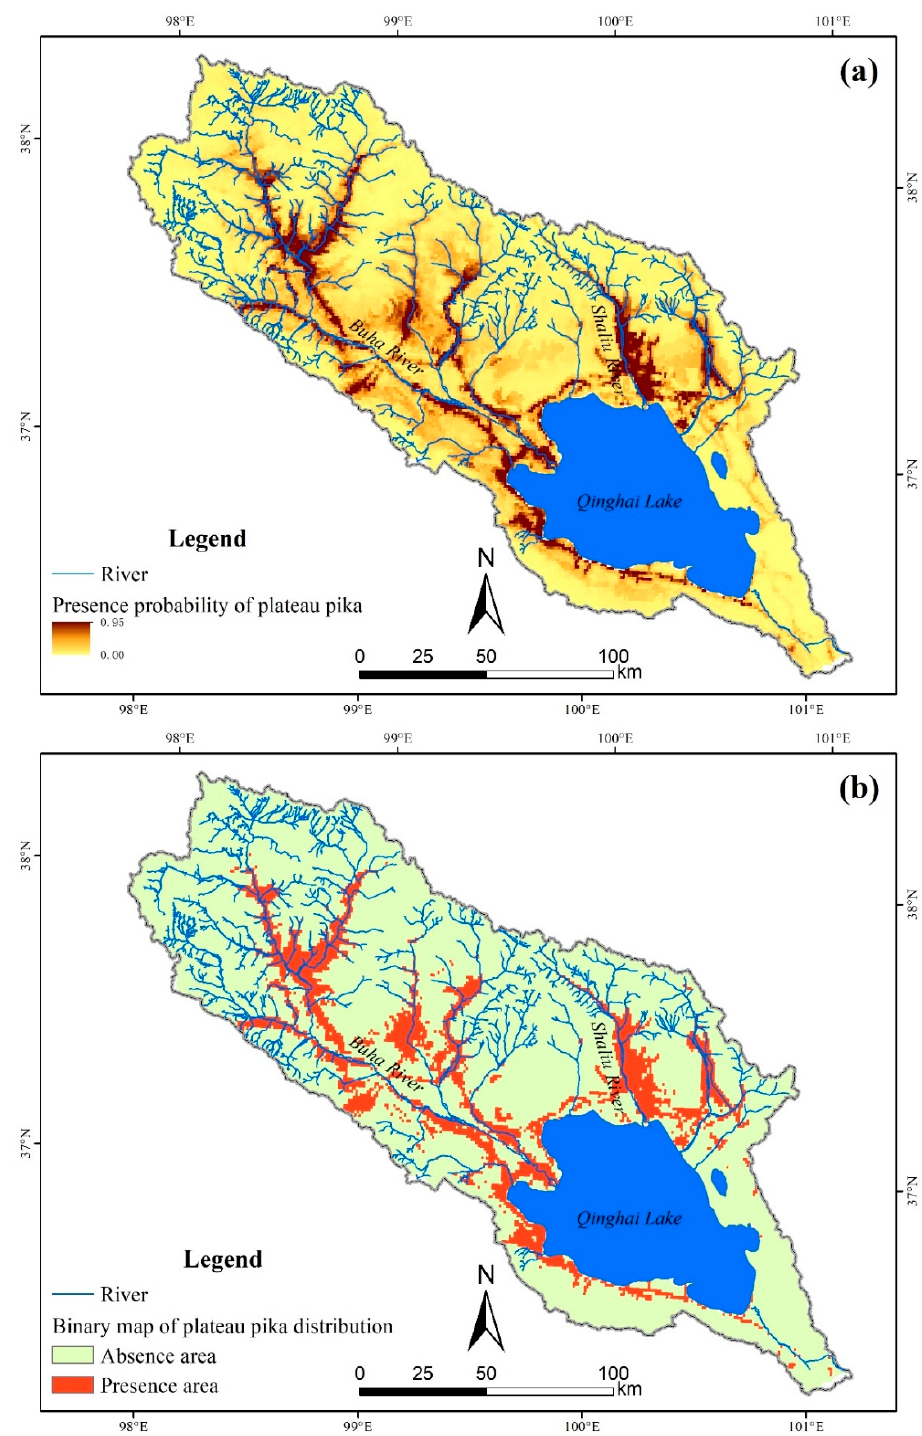
Figure 2. Presence probability map ( a ) and binary map ( b ) of plateau pika’s distribution in the Qinghai Lake basin. Lake